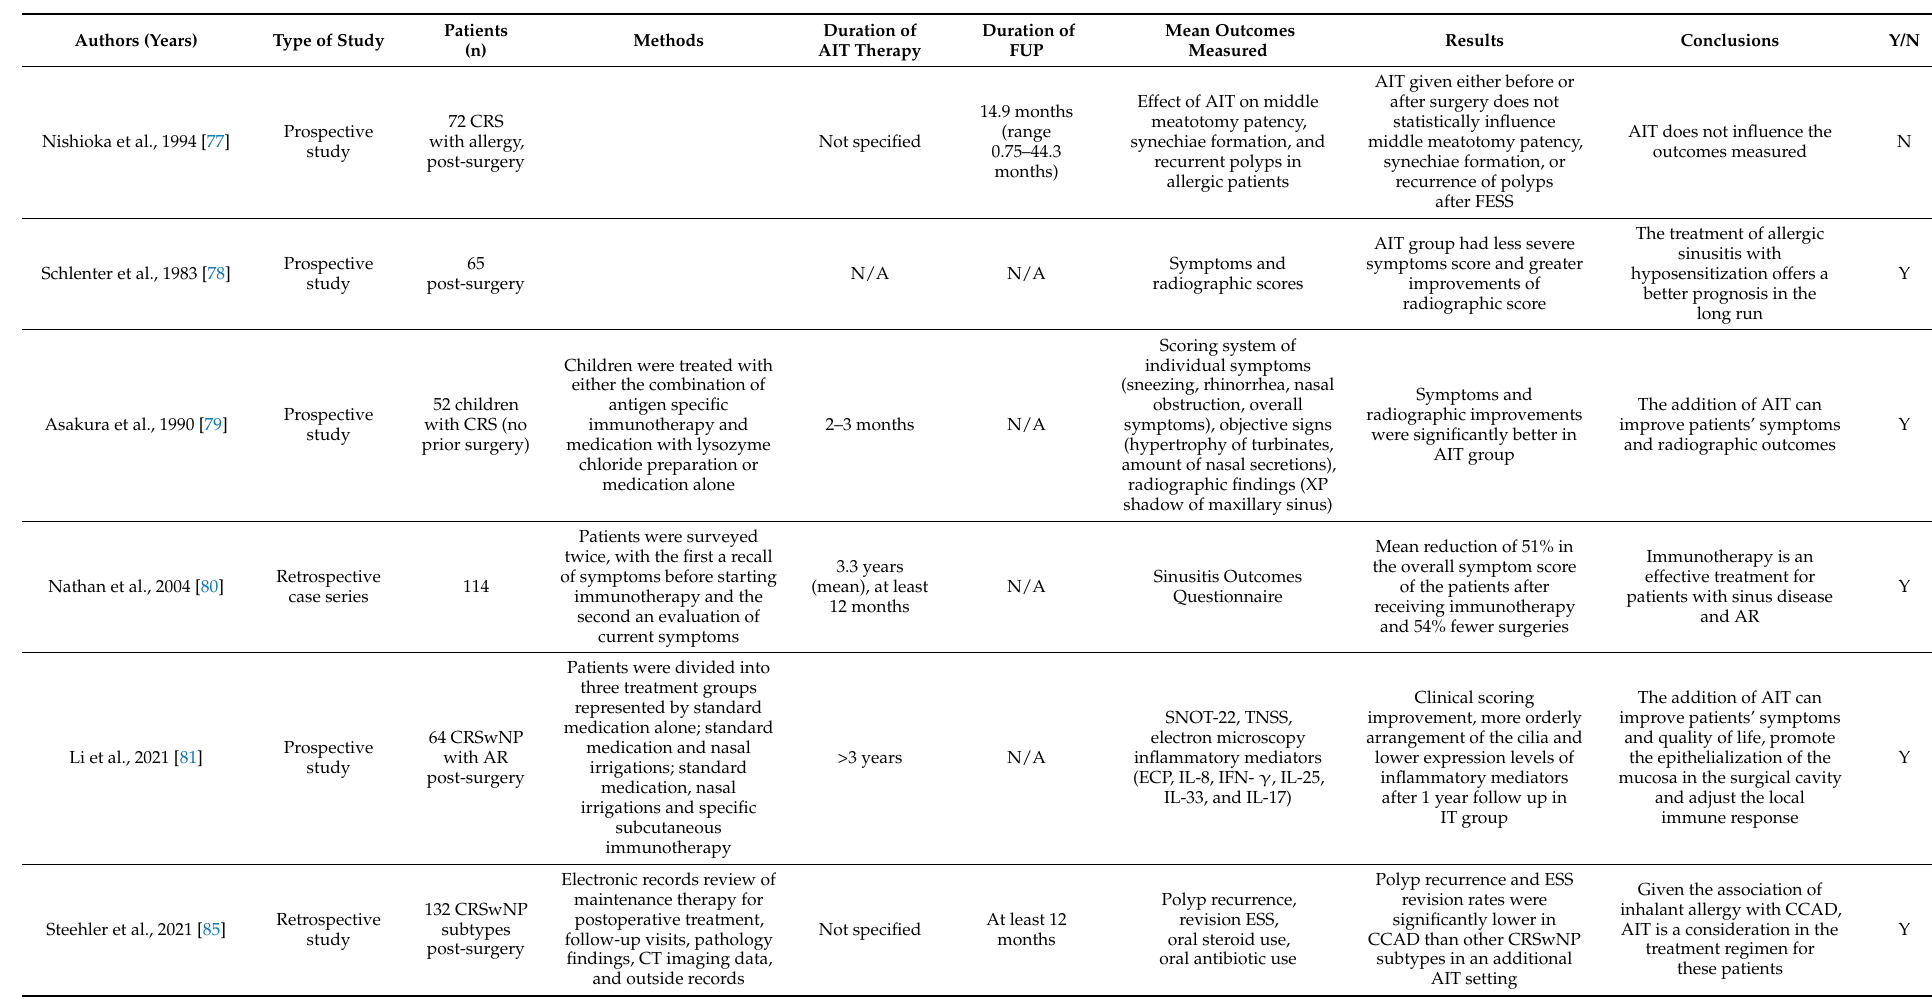
Table 2. Studies on efficacy of AIT in